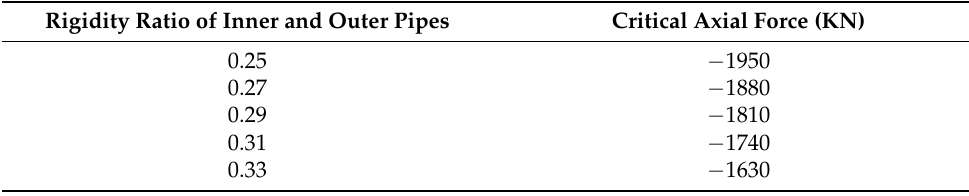
Figure 8. Influence of the rigidity ratio of inner and outer pipes in the axial force – lateral displacement graph. Table 6. Critical axial force of the rigidity ratio of inner and outer pipes.